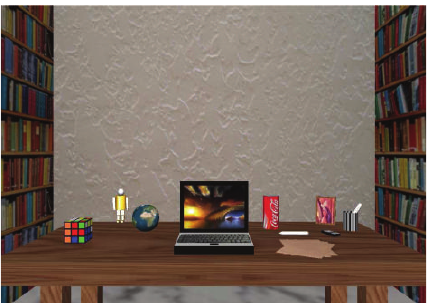
Figure 5: An example of the virtual scene designed for studying the robot behaviour adaptation on reaching tasks from a 3D perception in an unstructured